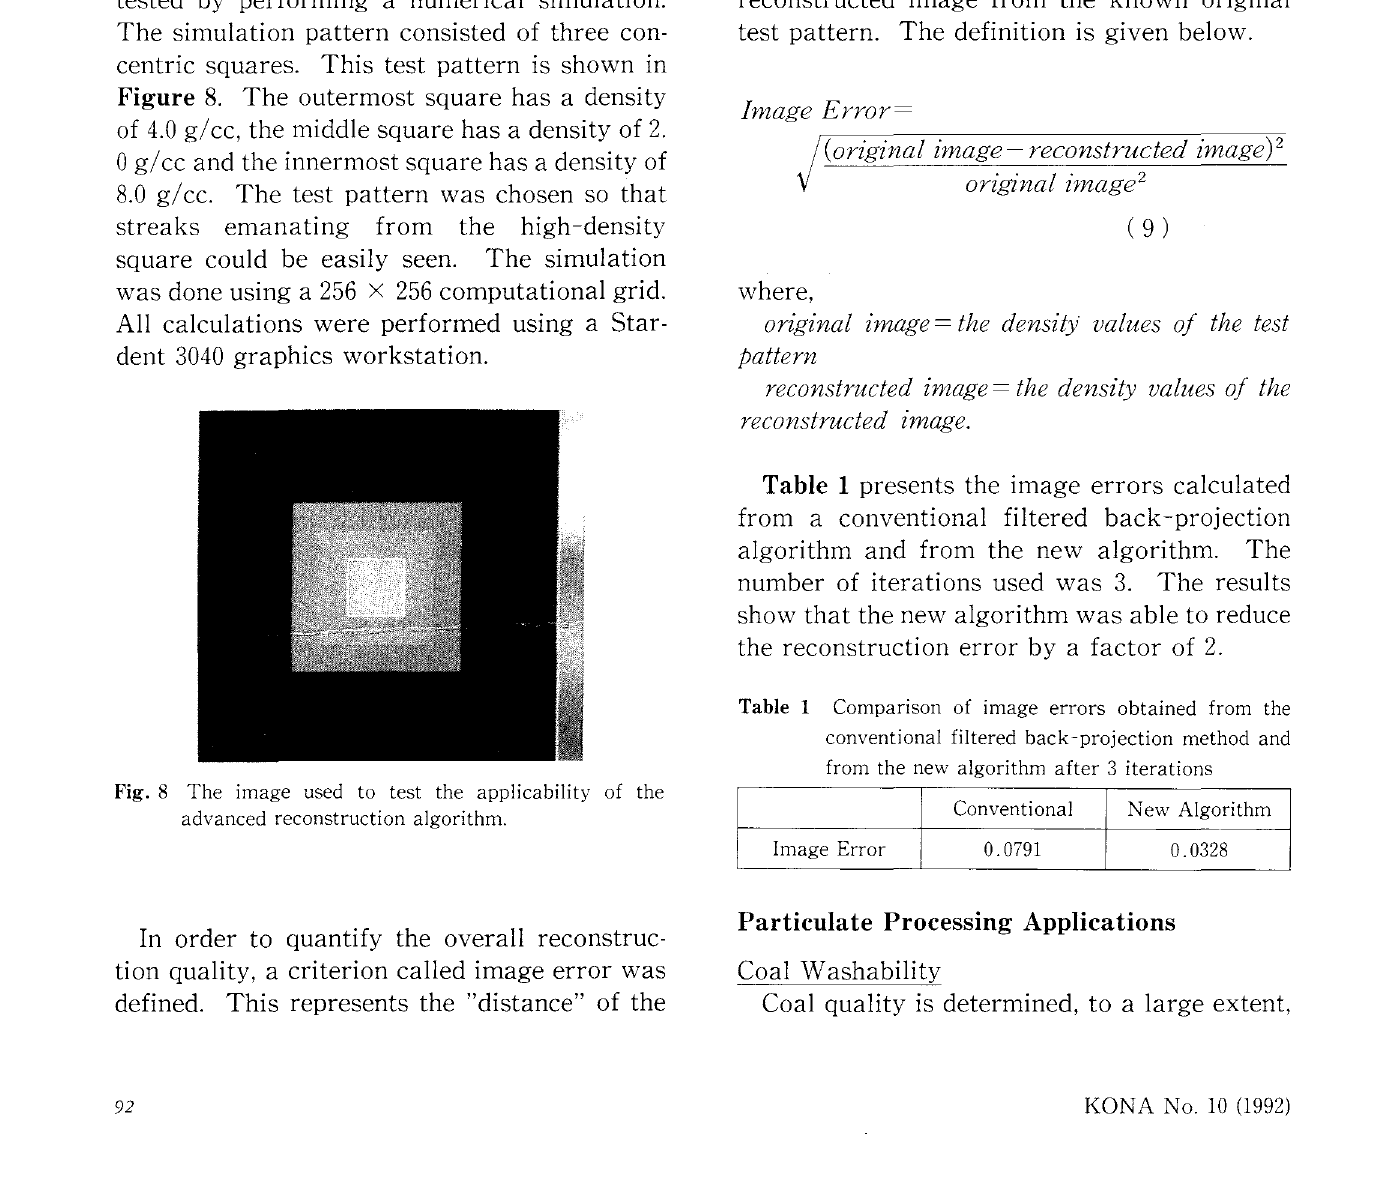
Fig. 7 A block diagram showing the various operations of the advanced algorithm. The operations enclosed in the dotted rectangle represent operations that are present in the conventional CT reconstruction algor ithm.